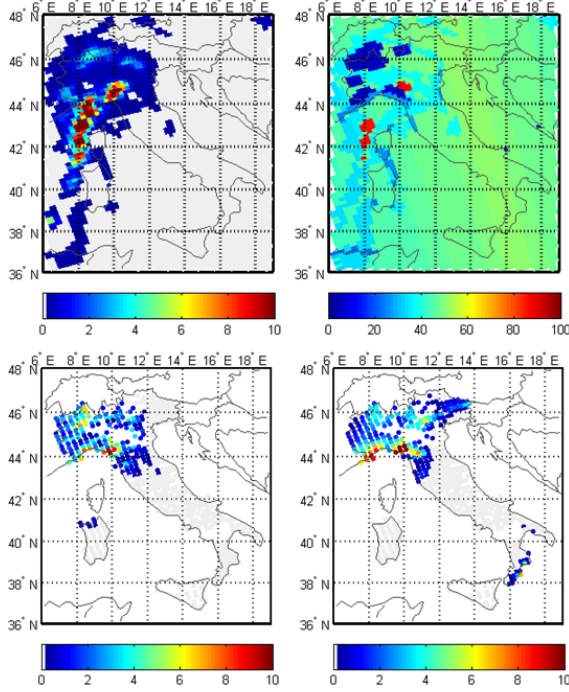
Figure 7. Flood over the La Spezia area (Italy, 44 ◦ N, 10 ◦ E), 25 Oc- tober 2011, 11:44UTC. PNPR surface precipitation rate (mmh − 1 ) (top left panel), “quality index” (top right panel), PNPR surface precipitation rate (mmh − 1 ) over land (bottom left) for compari- son with rain gauges data and 1h cumulated precipitation (11:00– 12:00UTC), from rain gauges, averaged over the IFOV and sam- pled (bottom